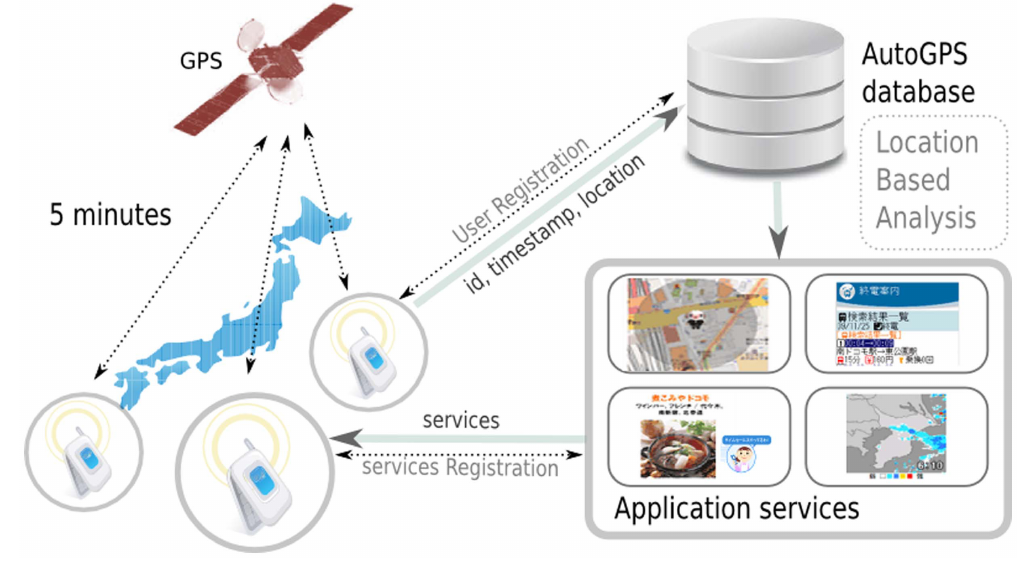
Figure 1. Overview of data collection process.